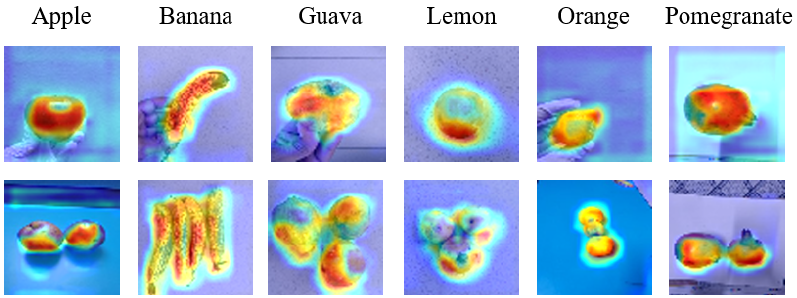
Figure 12. Highlights the class-specific discriminative regions for the predicted examples from our proposed network.